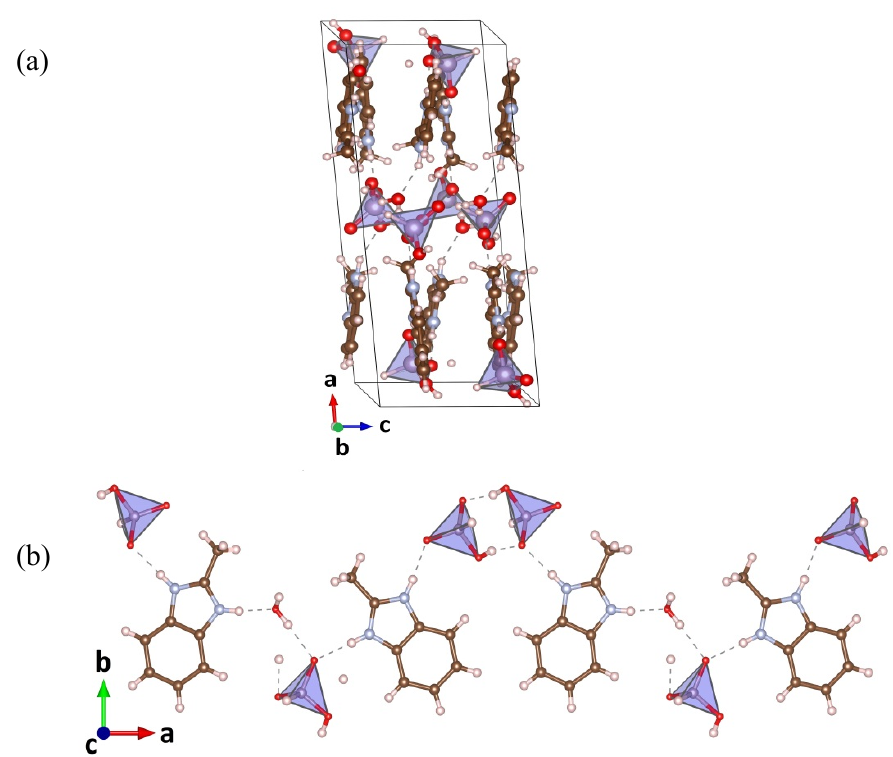
Figure 3. Crystal structure of MBI-phosphite (C 8 H 9 N 2 ) 2 (H 2 PO 3 ) 2 H 2 O (red balls are oxygen atoms, brown the carbons, gray the nitrogens, white the hydrogens, lilac the phosphorus). ( a ). Zig-zag chain along the a-axis in the structure ( b ).